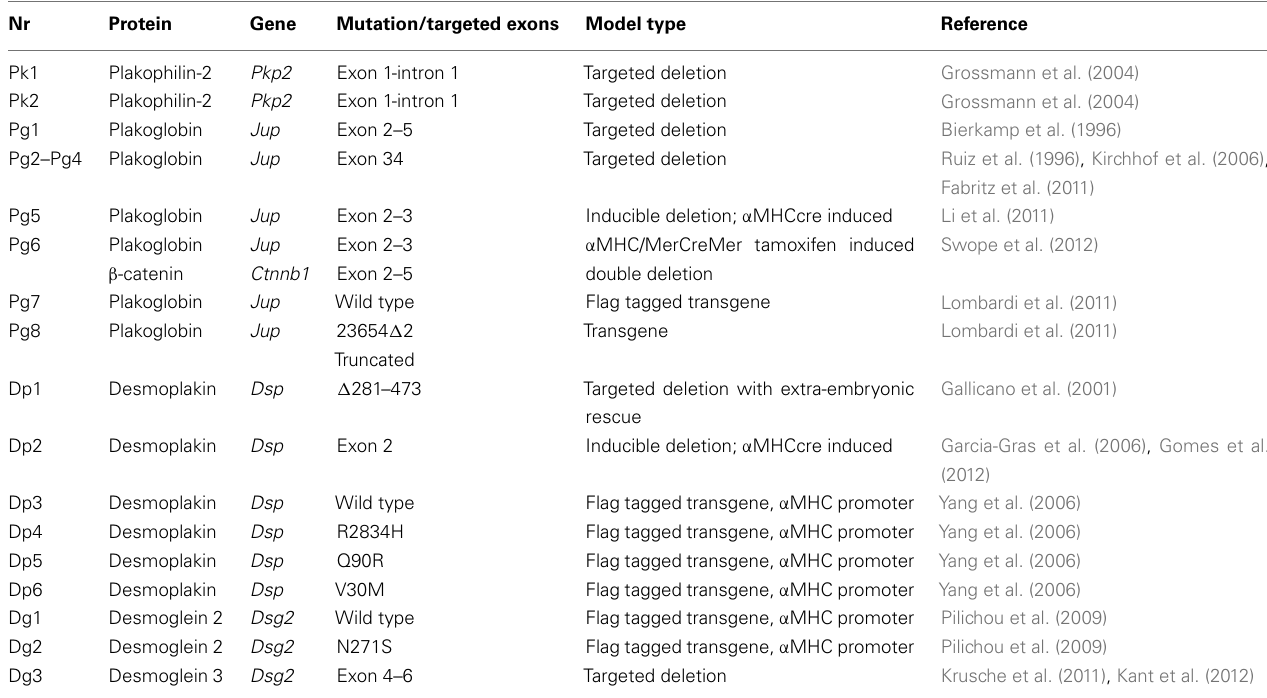
Table 1 |Arrhythmogenic right ventricular cardiomyopathy mouse